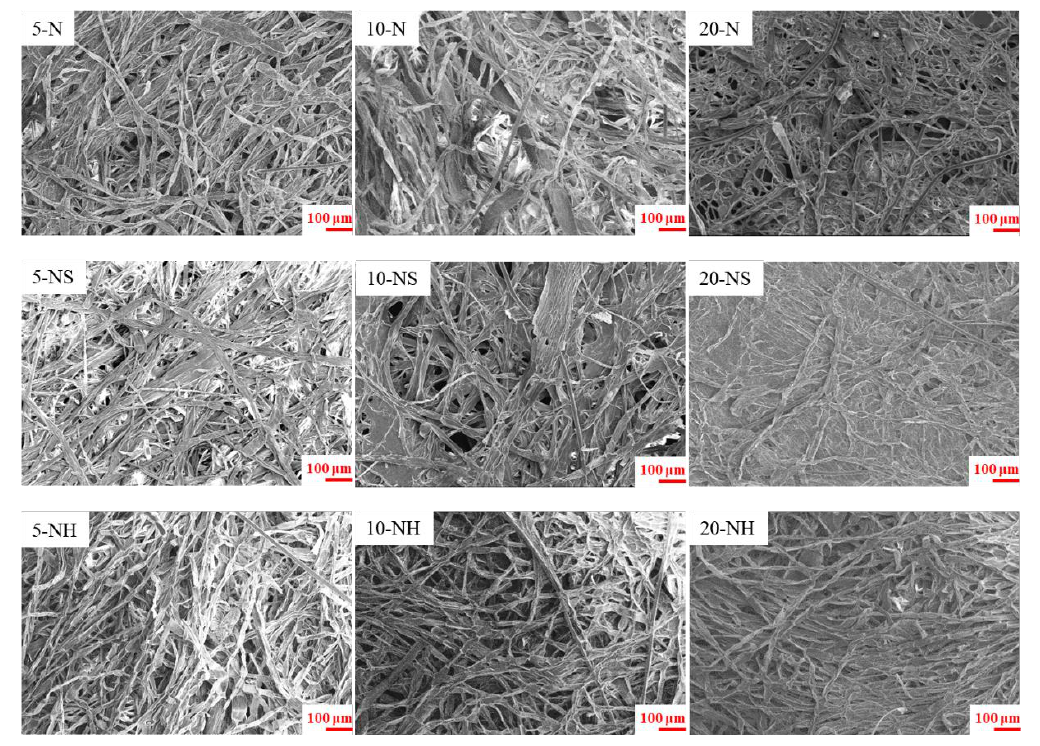
Figure 4. SEM images of Rhizoclonium pulp under different cooking treatments in handsheets.